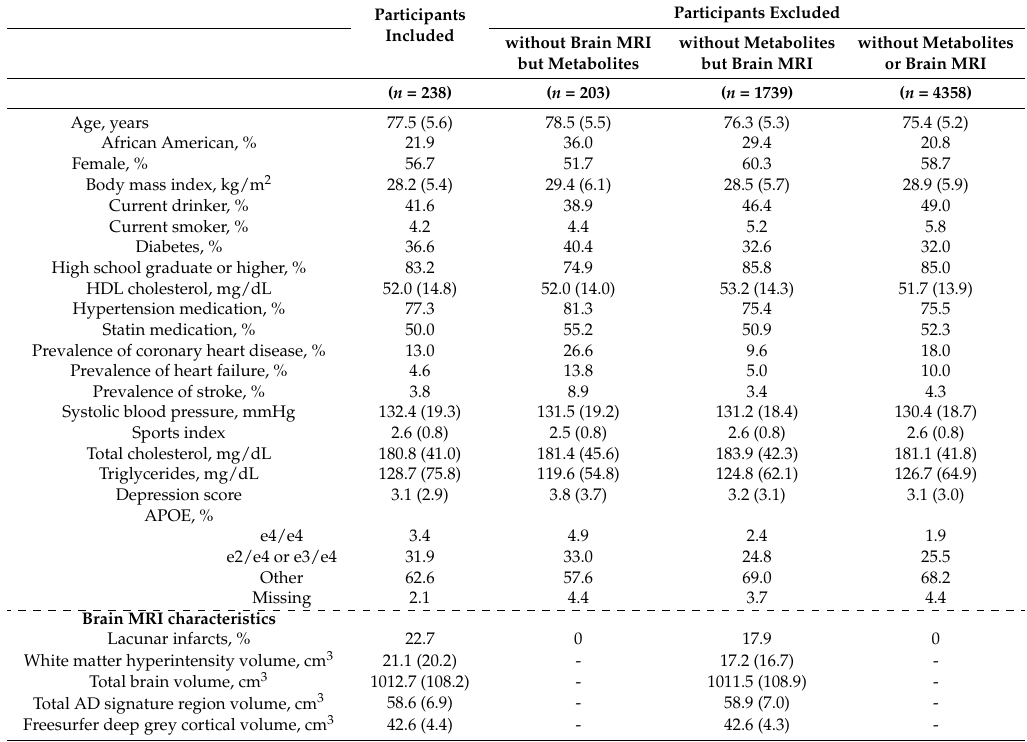
Data are shown as percentage for categorical variables and as mean (standard deviation) for continuous variables. MCI = mild cognitive impairment; MRI = Magnetic resonance imaging; AD = Alzheimer’s disease. Variables below the dashed line are only present in the brain MRI subset study from visit